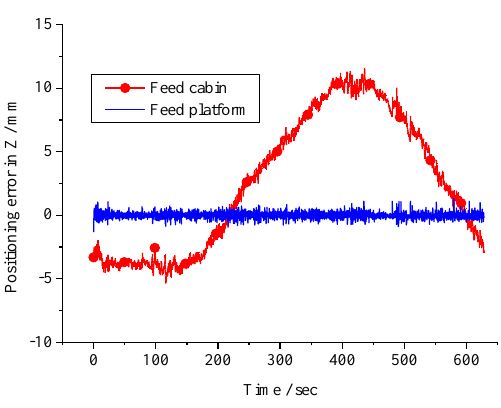
Figure 14. Positioning error in Y.